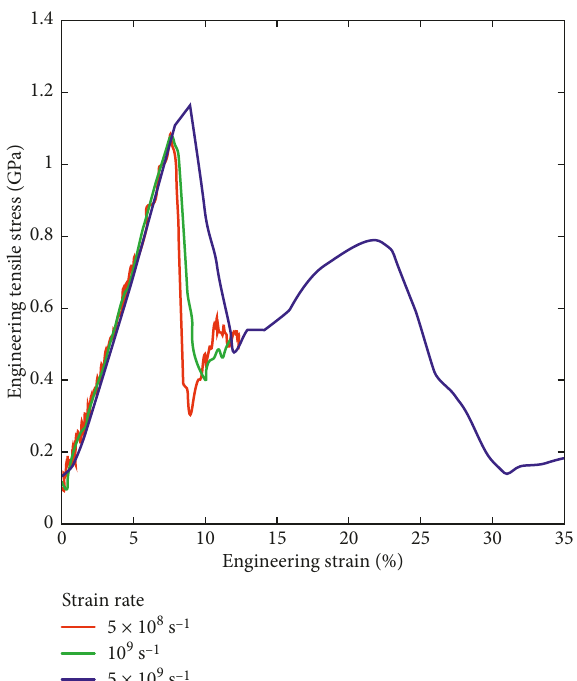
Figure 2: The effect of strain rate on strength of Au nanowire. The simulation parameters are same as those in Table